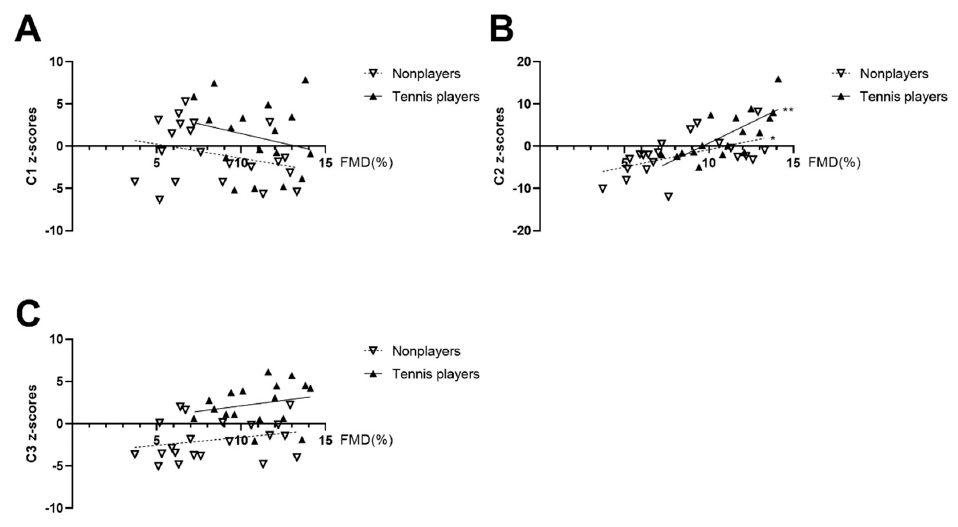
Figure 3. * p < 0.05 was considered statistically significant. ** p < 0.01 indicates a varying level of significance. Correlation of C1, C2, and C3 with increasing FMD between the tennis players and the nonplayers(A–C). Correlation of the cluster scores with increasing flow-mediated dilation between the tennis players and nonplayers. Cluster 1 (C1) represents the cardiac function and is the summary of the z-scores for the HR, SVI, CI, SV, CO, and EF; Cluster 2 (C2) represents the arterial function and is the summary of the z-scores for the FMD, WSS, CIMT, baPWV, ABI, PSV, and CAED; Cluster 3 (C3) represents the body composition function and is the summary of the z-scores for the BMI, BMP, BFM, and LBM.